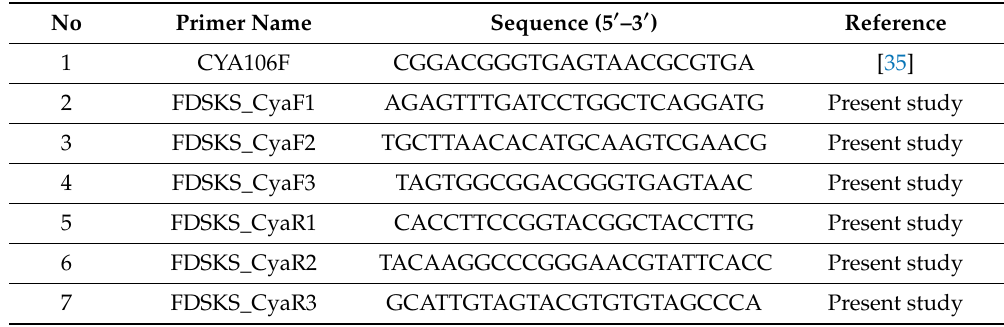
Table 1. Details of forward (1–4) and reverse (5–7) primers used in this study to amplify 16S rRNA gene of marine